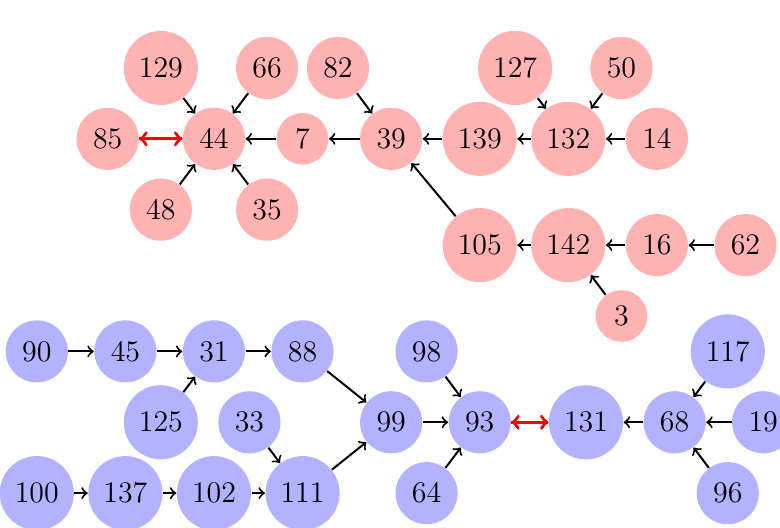
Figure 3: 2 components containing cycles of length 2